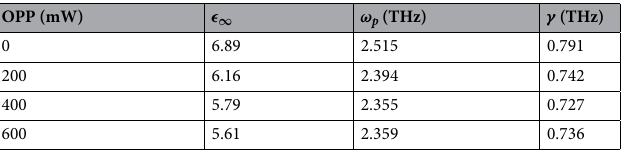
Table 1. Drude parameters. The in-plane effective permittivity tensor component in the case of 40 nm Bi vs. optical pumping power (OPP).